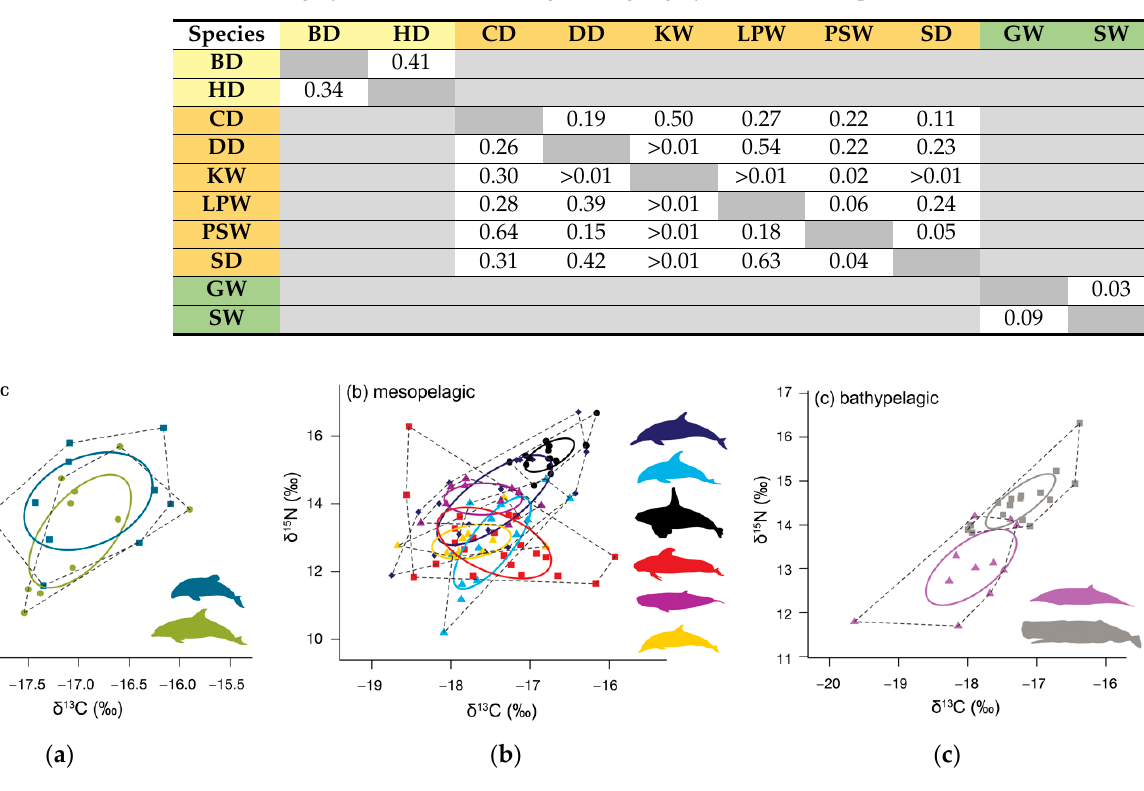
Figure 4. Standard ellipse area corrected for small sample size (SEA c , solid lines) and convex hull area (TA, dotted line) for adults. ( a ) neritic odontocetes: bottlenose dolphins ( Tursiops truncatus , olive green), Hector’s dolphins ( Lagenorhynchus obscurus , teal), ( b ) mesopelagic odontocetes: common dolphins ( Delphinus delphis , dark blue), dusky dolphins ( Lagenorhynchus obscurus , light blue), killer whales ( Orcinus orca , black), pygmy sperm whales ( Kogia breviceps , magenta), long-finned pilot whales ( Globicephala melas , red), and striped dolphins ( Stenella coeruleoalba , yellow), and ( c ) bathypelagic odontocetes: Gray’s beaked whales ( Mesoplodon grayi , purple) and sperm whales ( Physeter macrocephalus , grey). Ellipse areas hold 40% of the data.